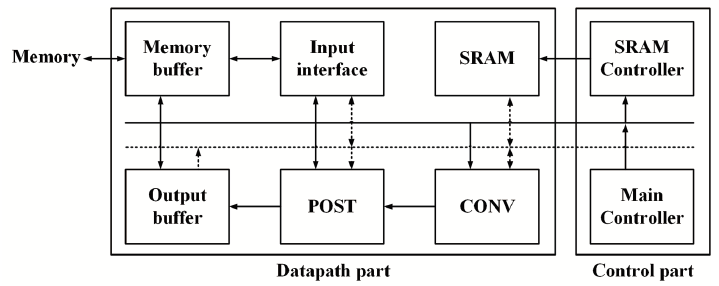
Figure 3. Top architecture of the proposed